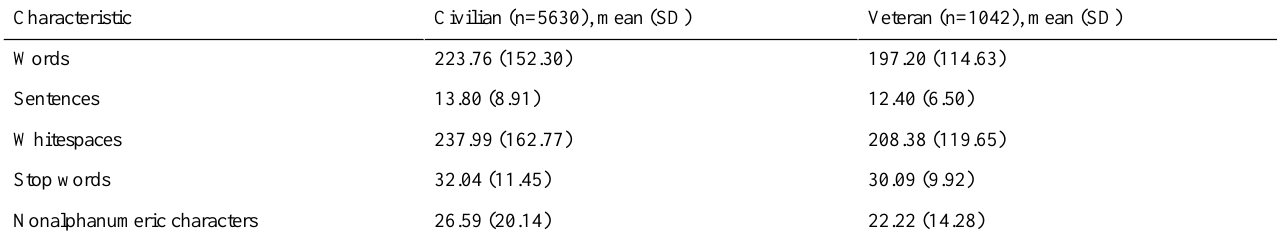
Table 2. Document characteristics including frequency and mean (SD) for annotated personal history statements stratified by civilian and veteran